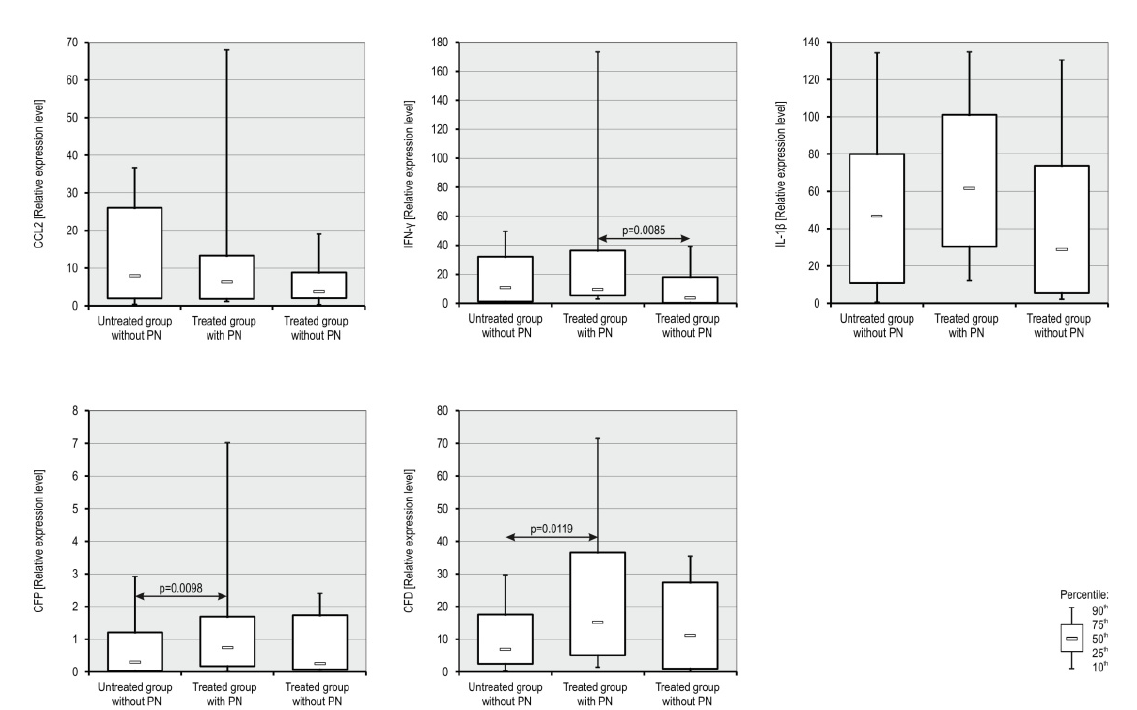
Figure 3. Box and whisker plot of gene expression levels in patients with MM. The boxes extend from the 25th percentile to the 75th percentile; the whiskers represent the 90th percentile and 10th percentile coefficients and the small black box indicates the expression median.